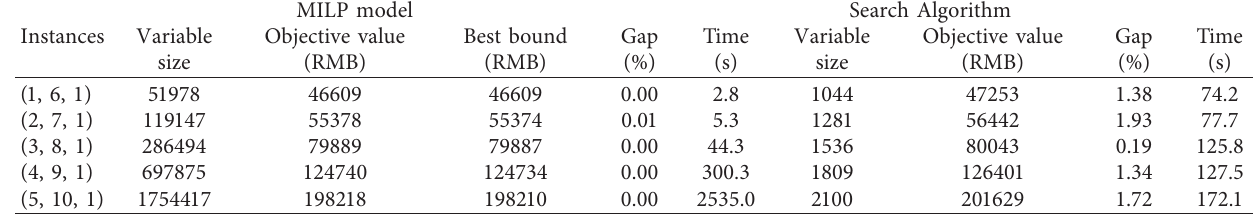
Table 3: Computational results of the